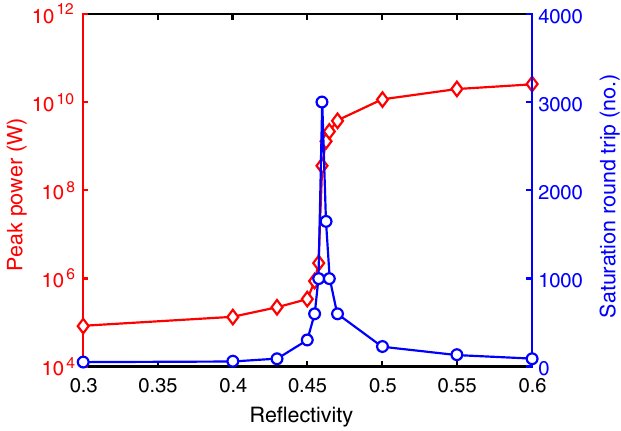
FIG. 2. The XFELO output peak power and saturation round trip number as a function of cavity output mirror reflectivity.